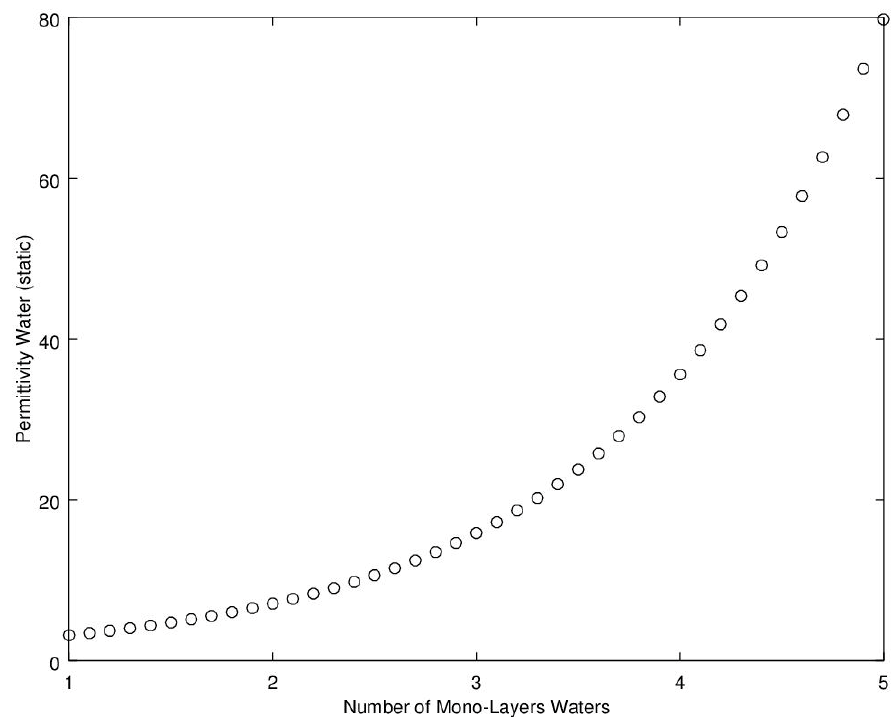
Figure 2. Detail illustrating how the real portion of complex permittivity of bound water, at 20 °C, varies as the water molecules move away from the surface of the material. Mono-layer 1 is closest to the surface of the material (each mono-layer of water is approximately 1.5 × 10 − 10 m), and exhibits a permittivity nearly equivalent to that of ice (water in a tightly bound crystalline matrix form that is highly resistant to pivoting in a rapidly rotating electric-field).